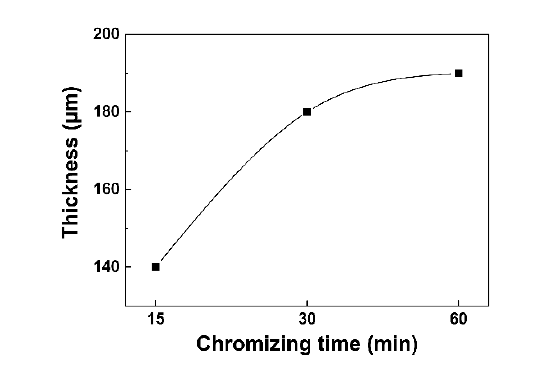
Figure 6. Evolution of the coating thickness with the increasing of chromizing